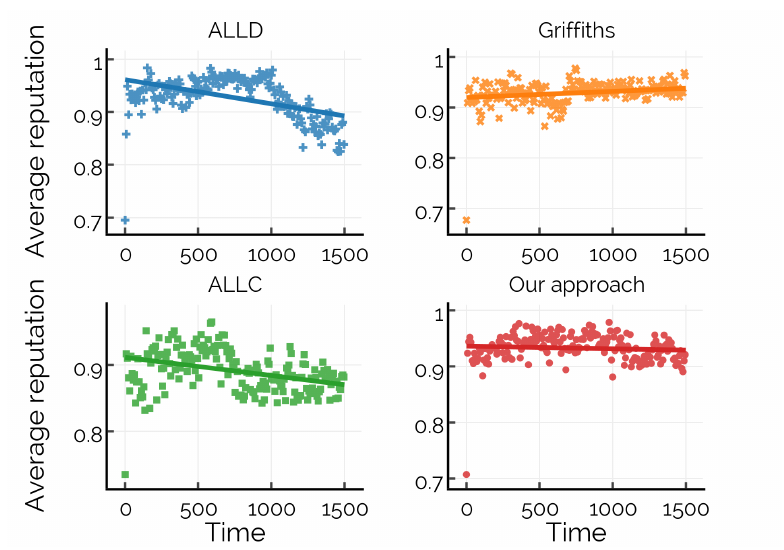
Figure 4. Average reputation of each